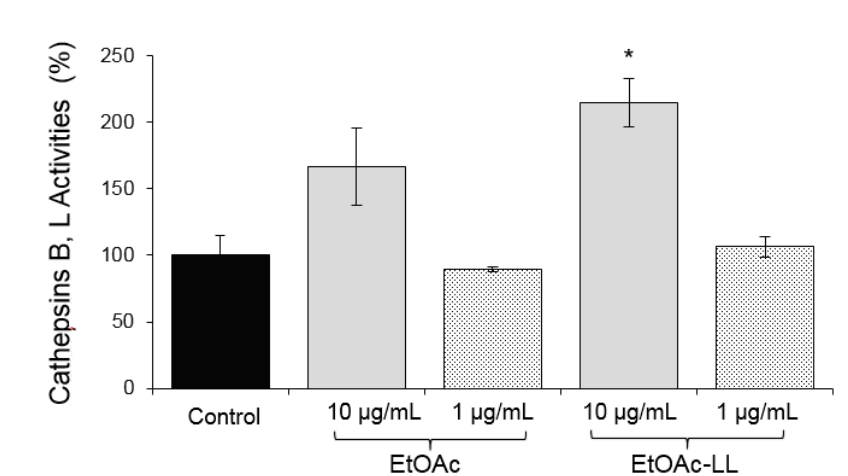
Figure 2. Relative (%) cathepsins B, L activities in normal replicating (young) human fibroblasts after 24 h of treatment with the EtOAc and EtOAc-LL extracts of the strain CF-092983 at concentrations of 10 µ g / mL and 1 µ g / mL. Bars, ± SD ( n = 3). * p < 0.05. Controls (cells treated with the vehicle / DMSO) were set to 100%.